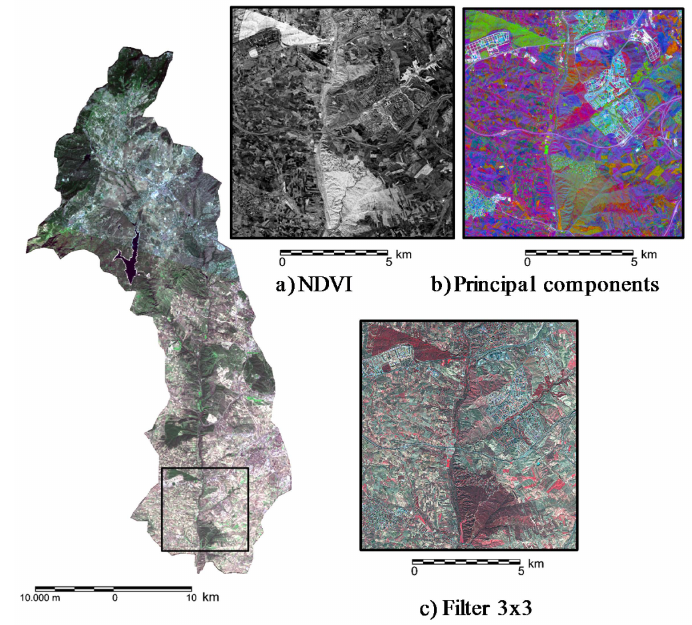
Figure 2. Digital analysis of Spot image.